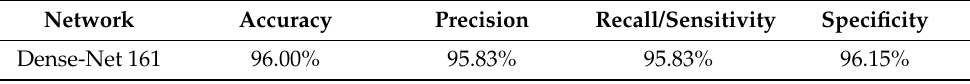
Table 6. The evaluation results of the first experiment on INRIA and MSMT17